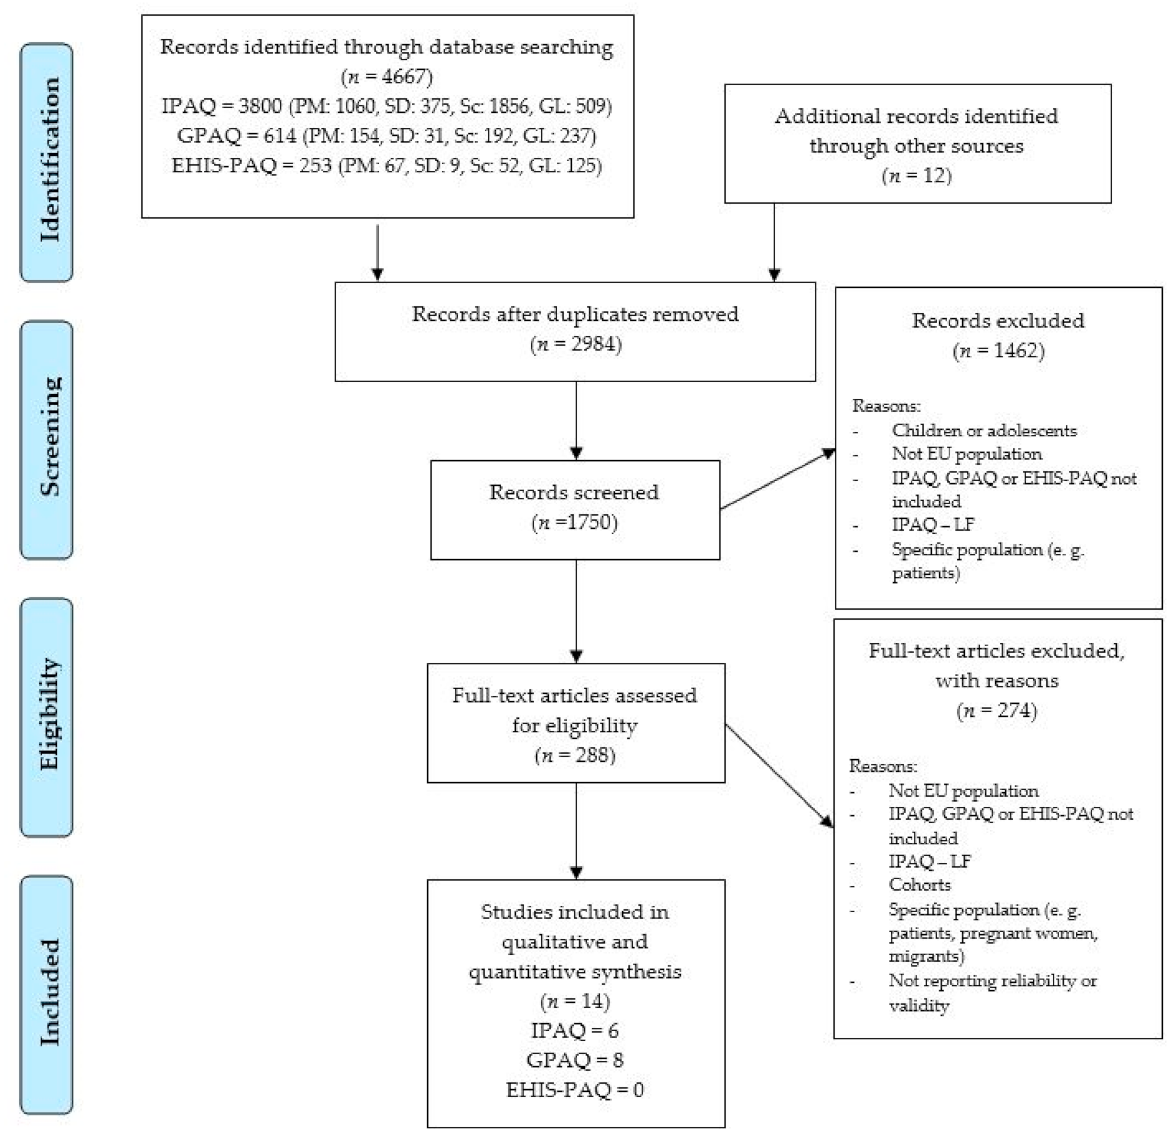
Figure 1. Flowchart showing study identification process. PM—PubMed; SD—SportDiscus; Sc—Scopus; GL—grey